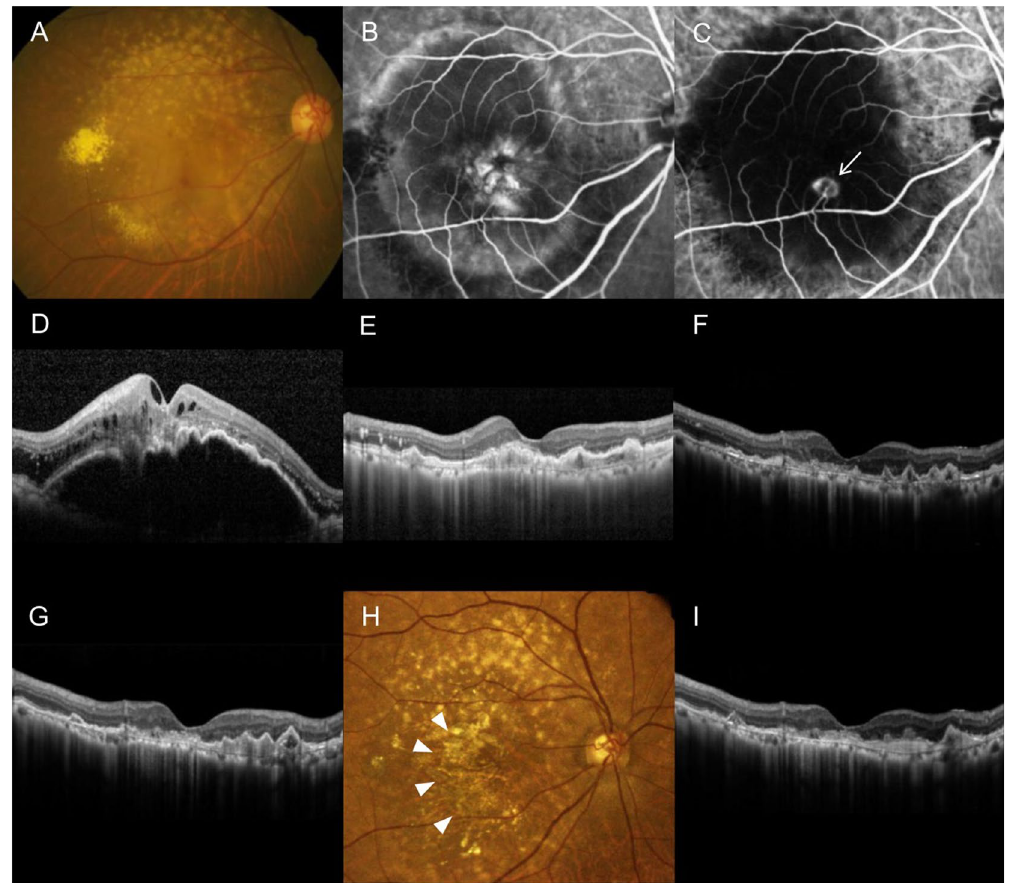
Figure 3. A representative case showing the clinical course of a patient in the no-reactivation group. A 76-year-old patient diagnosed with type 3 macular neovascularization (MNV) ( A – D ). The best-corrected visual acuity (BCVA) is 20/400. After three monthly aflibercept injections, retinal edema completely resolved ( E ). Optical coherence tomography (OCT) images taken at 11 months ( F ) and 18 months ( G ) show no evidence of lesion reactivation. No additional injection was required during the 24-month follow-up period. At 24 months ( H , I ), there is no lesion reactivation and the BCVA is 20/400. On fundus photography, retinal pigment epithelial atrophy is noted (( H) , arrowheads). ( A) , ( H) = fundus photography; ( B ) = fluorescein angiography; ( C) = indocyanine green angiography; ( D - G) , ( I) = OCT. The arrow in panel ( C) indicates a type 3 MNV